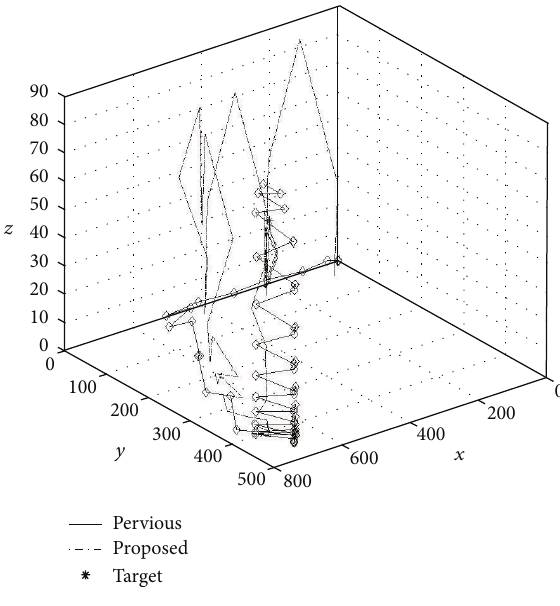
Figure 11: 3D locus